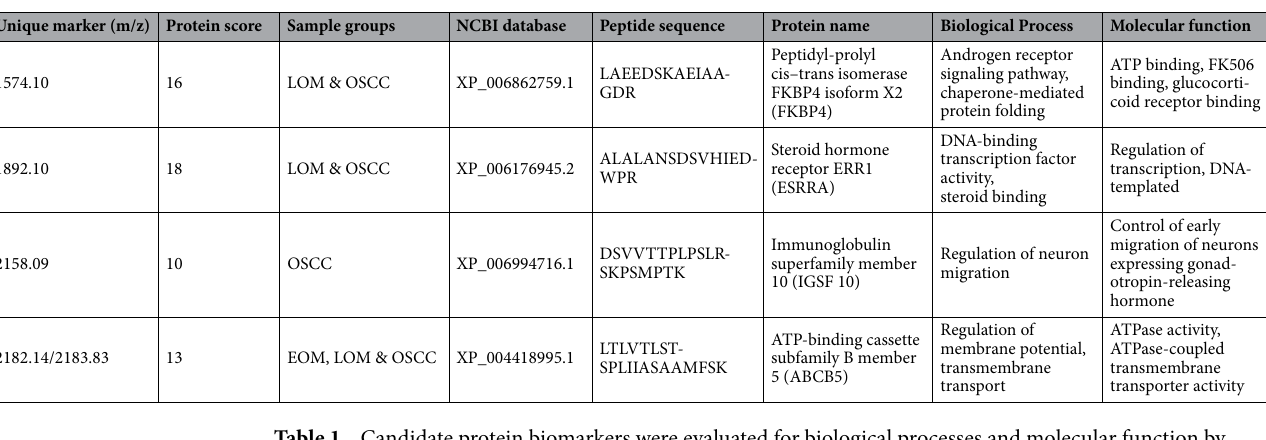
Table 1. Candidate protein biomarkers were evaluated for biological processes and molecular function by UniProtKB/Swiss-Prot.